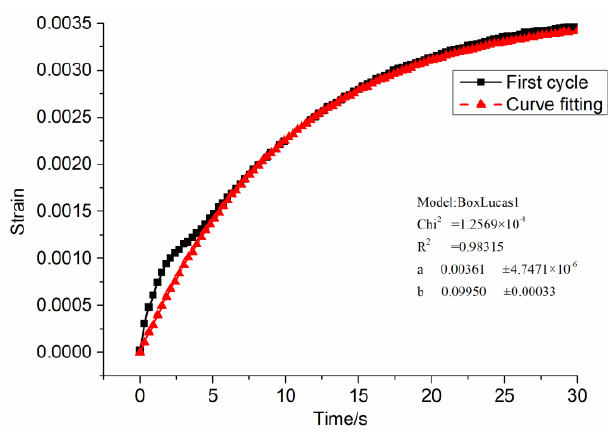
Figure 8. Nonlinear regression of the first cycle viscoelastic strain time curve of SAC-13.